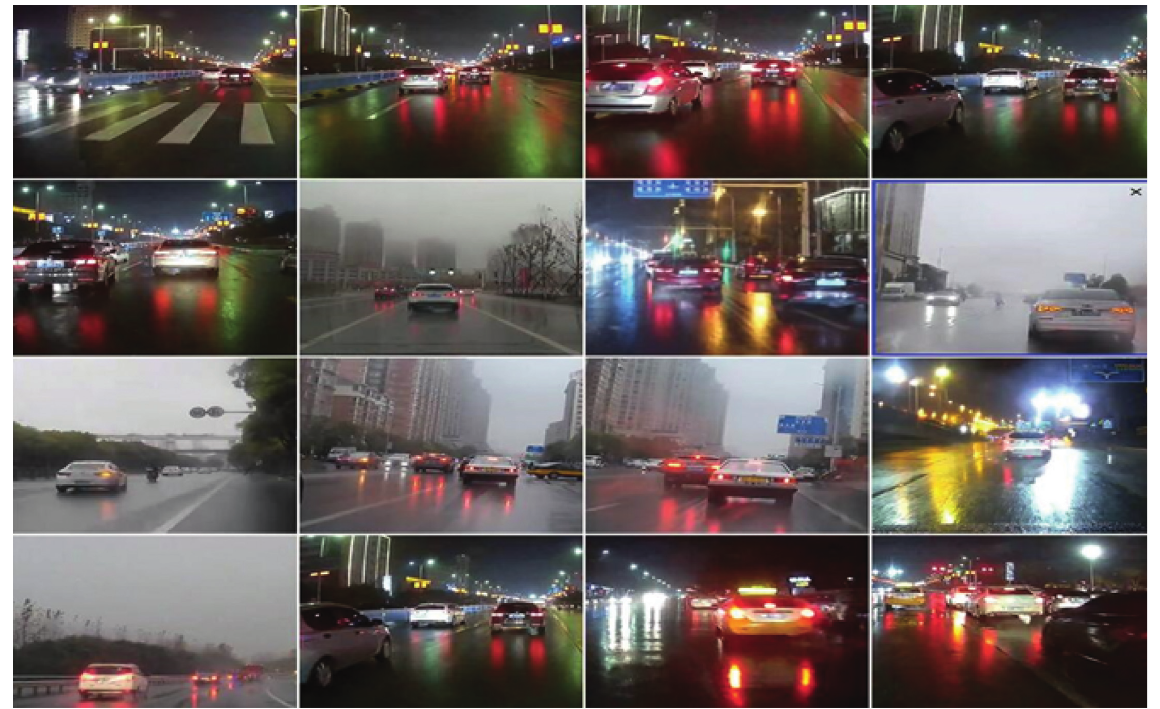
Figure 23: A partial sample of the VIDAR-Reflection Road data set.